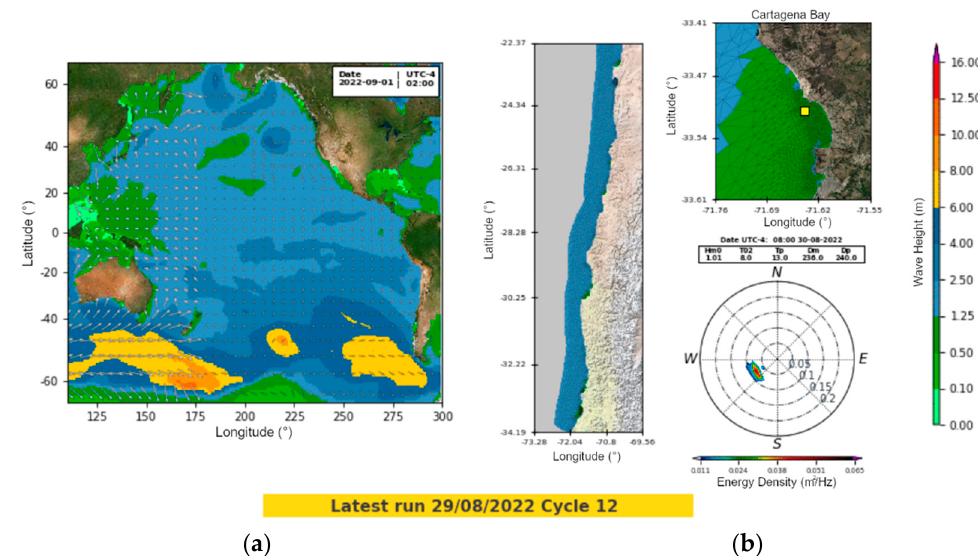
Figure 3. Wave forecast system using the WaveWatch III model in Cartagena Bay: ( a ) global grid, 0.5° resolution; ( b ) unstructured mesh and high-resolution mesh in Cartagena Bay.